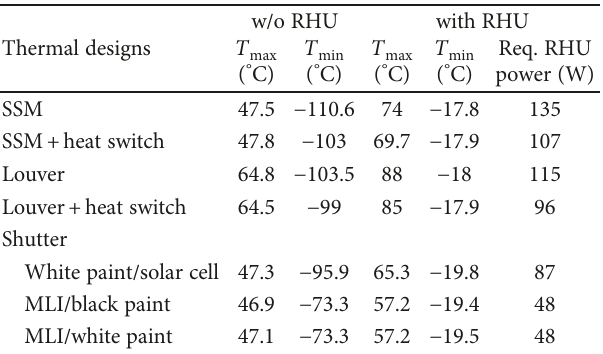
Table 5: Maximum and minimum temperatures and RHU power for a lunar lander with various thermal control